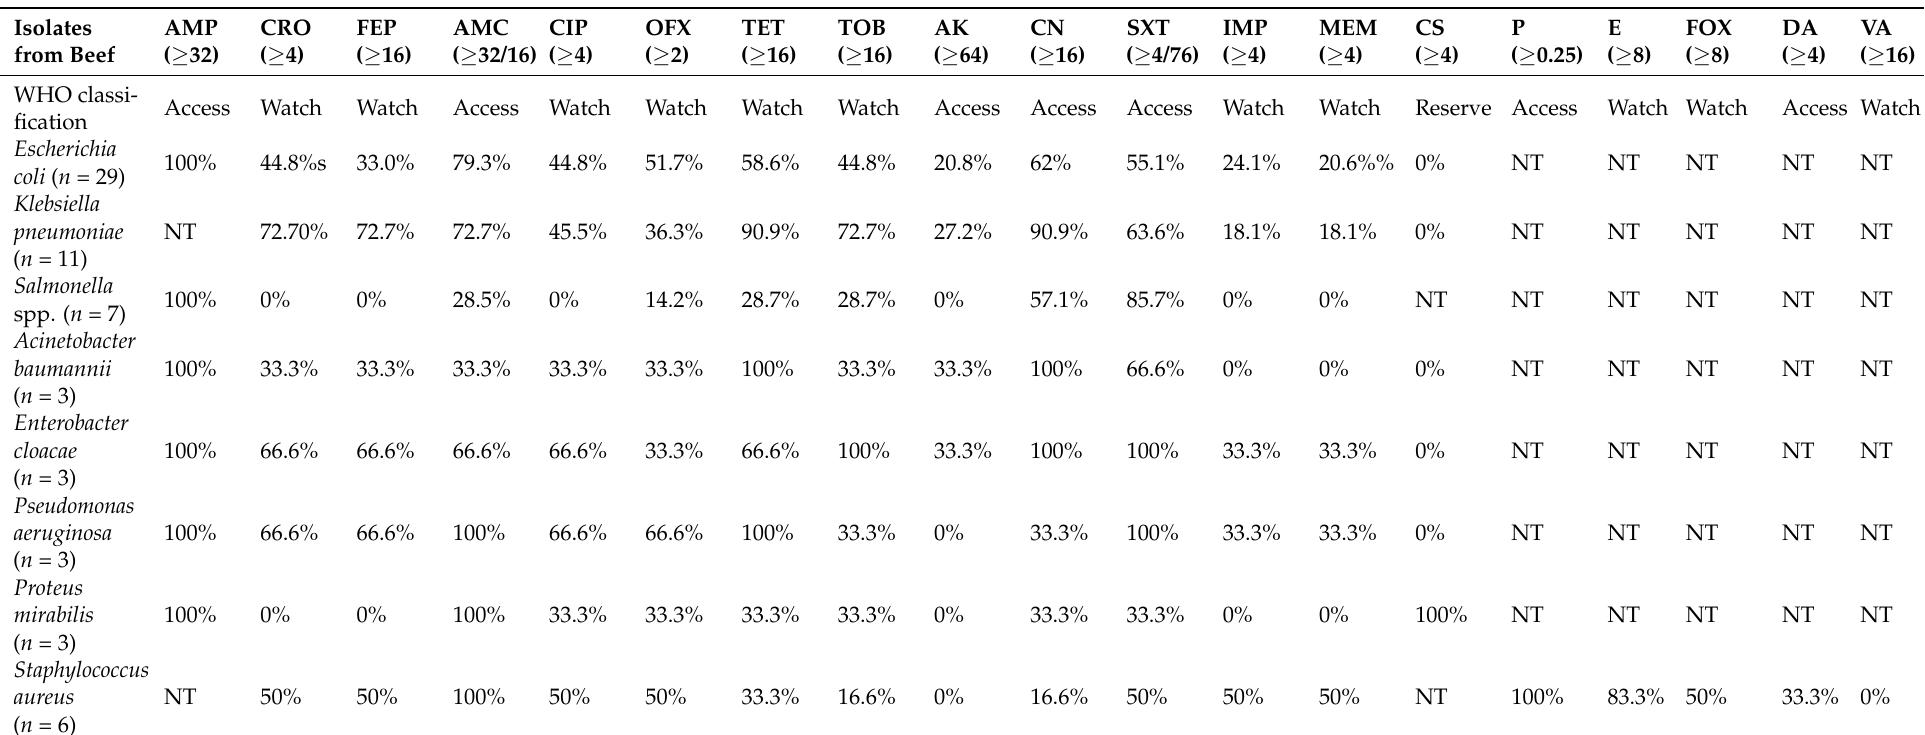
Table 3. Antimicrobial resistance profile (minimum inhibitory concentration [ µ g/mL]) of bacteria isolated from beef